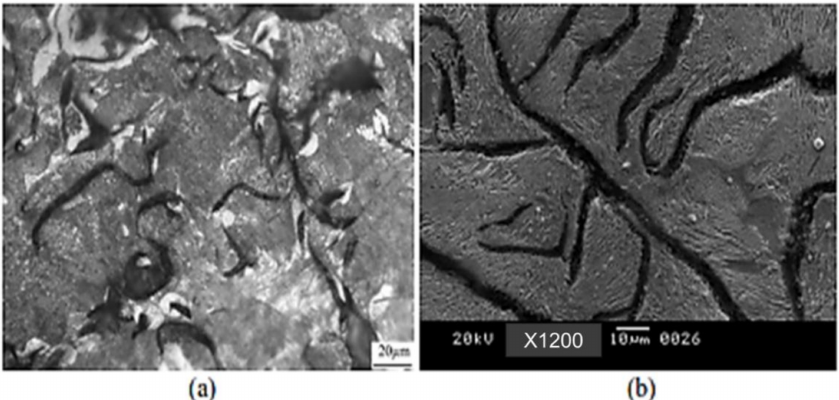
Figure 23. ( a ) Visual microstructure and ( b ) morphological structure of as-cast gray iron [44].